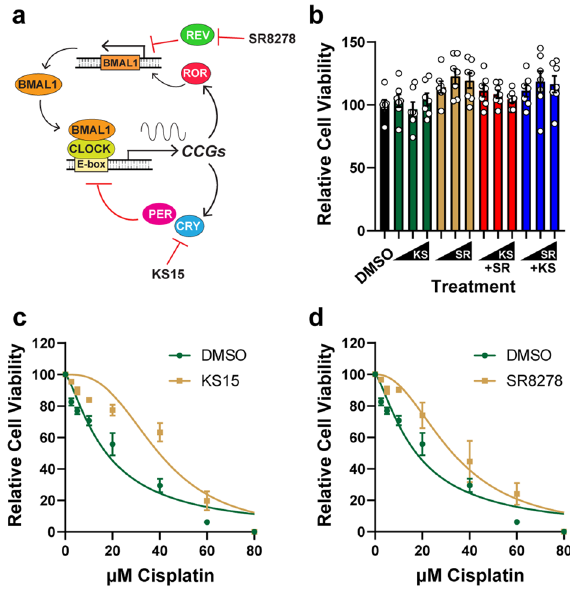
Figure 1. The cryptochrome inhibitor KS15 and REV-ERB antagonist SR8278 protect U2OS cells against cisplatin treatment. (a) Schematic of the circadian clock transcription-translation feedback loop. The CLOCK- BMAL1 complex binds E-boxes in the promoters of target clock-control genes (CCGs), including the period (PER) and cryptochrome (CRY) that feedback to inhibit CLOCK-BMAL1 activity. Expression of BMAL1 is regulated by the retinoic acid receptor-related orphan receptor (ROR) and REV-ERB (REV) proteins that competitively bind to ROR elements (RORE) in the BMAL1 promoter. The CRY inhibitor KS15 and REV-ERB antagonist SR8278 have been shown to impact target gene and promoter activities. (b) U2OS cells were treated for 2 days with vehicle (0.1% DMSO) or increasing concentrations (10, 20, 50 µM) of KS15 (KS) and SR8278 (SR) in the absence or presence of 10 µM of the other compound. MTT assays were performed to measure relative cell viability (average and SEM, n = 7). (c) U2OS cells were treated with DMSO or 50 µM KS15 and